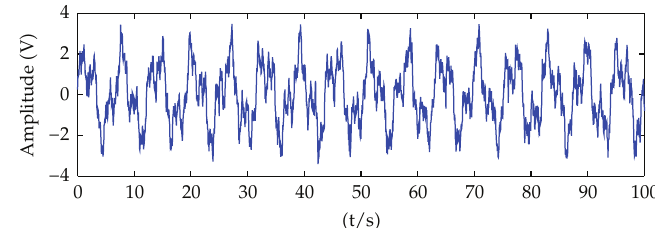
Figure 3: The estimated fractional signal based on multiscale wavelet transform.